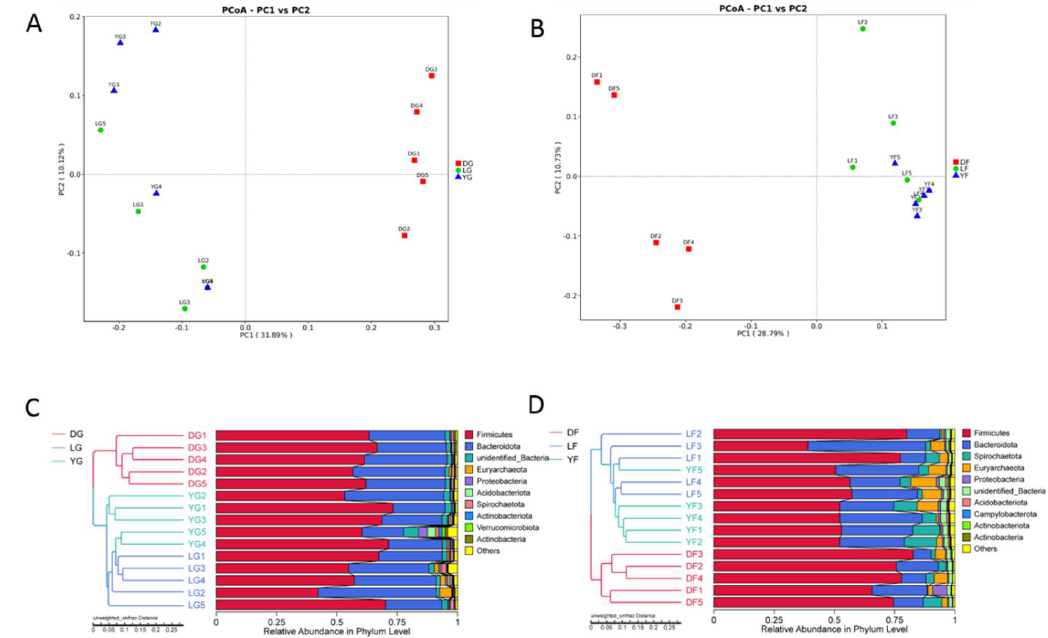
Figure 4. ( A , B ) Principal coordinate analysis (PCoA) and ( C , D ) unweighted pair group method with arithmetic means analysis (UPGMA) based on unweighted Unifrac distances of the phylum-level relative abundance in the gut microbiota of Duroc, Landrace and Yorkshire pigs at both early and finishing growth stages. DG—Duroc at early growth stage; LG—Landrace at early growth stage; YG—Yorkshire at early growth stage; DF—Duroc at finishing stage; LF—Landrace at finishing stage; YF—Yorkshire at finishing stage.